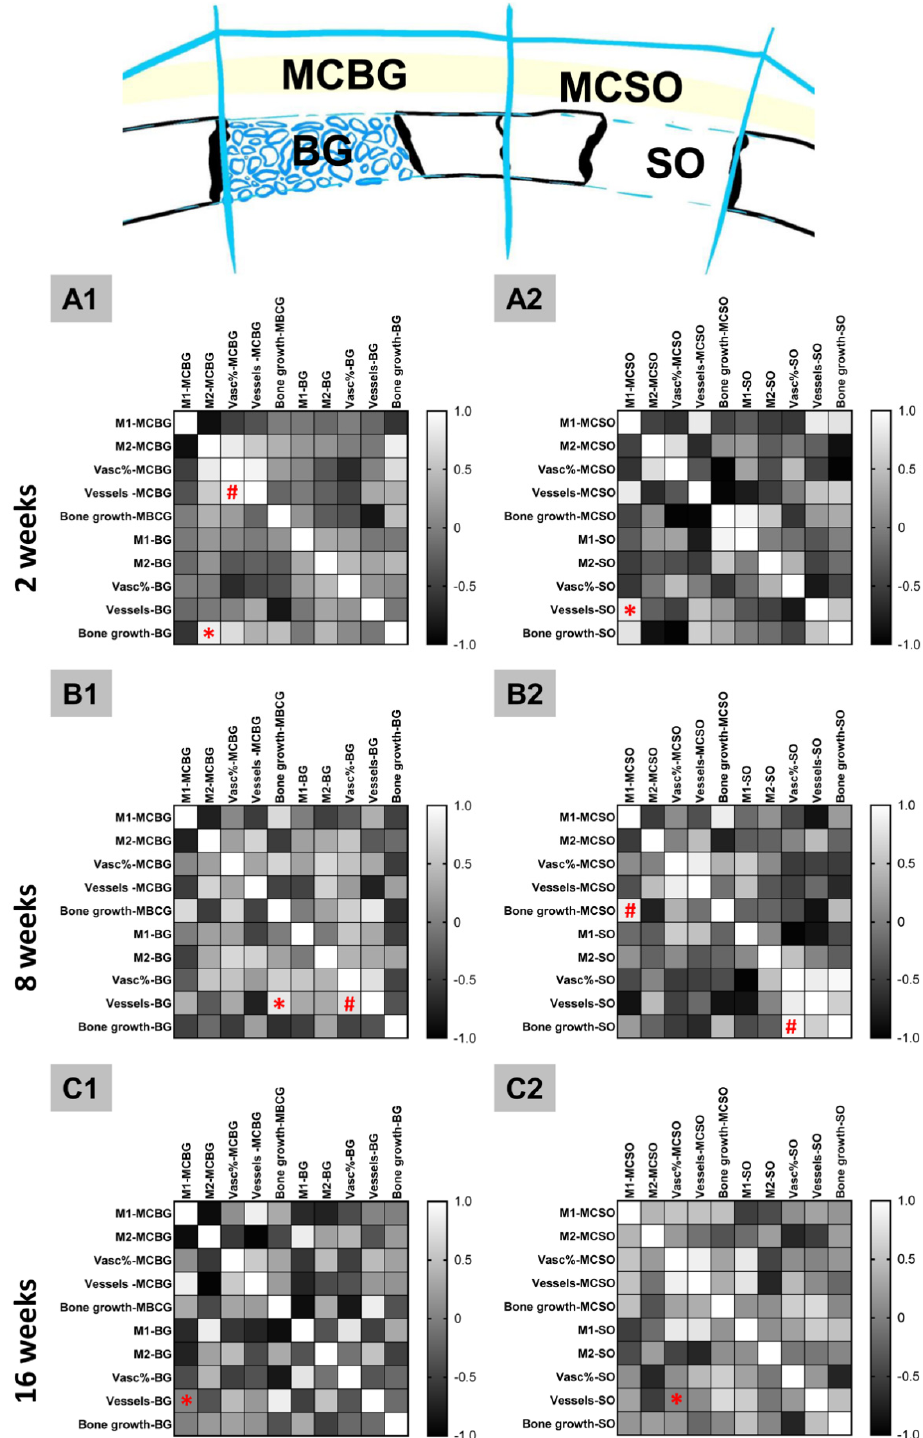
Figure 6. Correlation matrices between all measured variables within and between overlying com- partments, i.e., the MCBG and the BG compartments (left row, A1 – C1 ) and the MCSO and the SO compartments (right row, A2 – C2 ) at 2, 8, and 16 weeks post implantationem. Asterisks = sig-nificances between compartments; hashtags = significances within a compartment. MCBG: mem-brane com- partment above bone graft-filled defects; MCSO: membrane compartment above sham operation; BG: bone graft-filled defect; and SO: sham operation bone